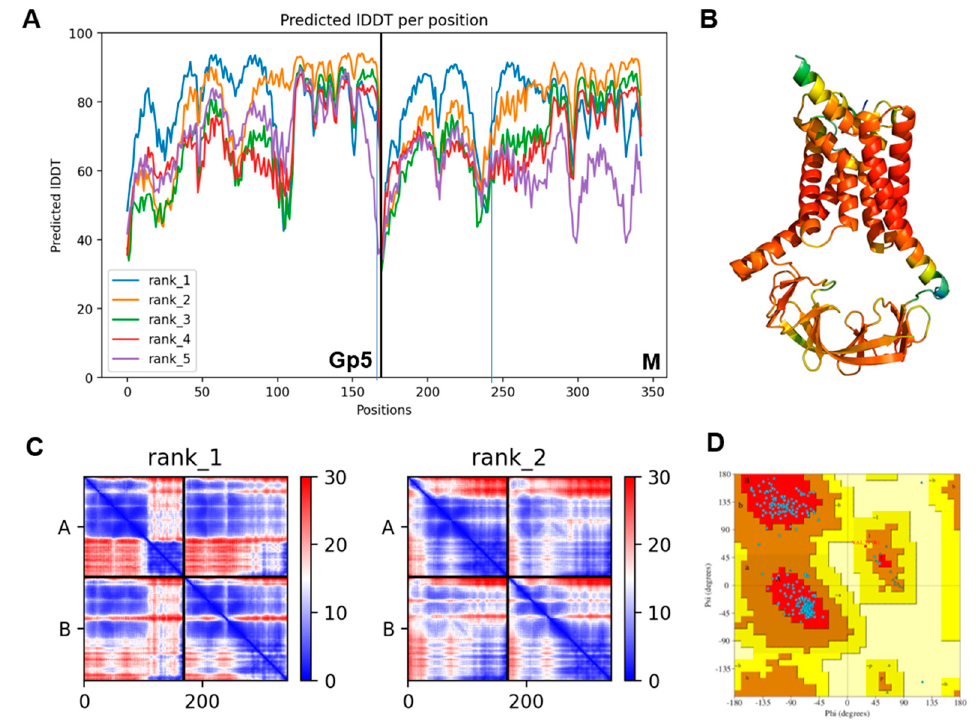
Figure 1. Confidence metrices for the predicted structure of Gp5/M of PRSSV-2 strain VR 2332: ( A ) Predicted local distance difference test (LDDT) score per position for the five models generated by alphafold2. The amino acid position is plotted against the predicted LDDT. Values between 70 and 90 indicate a high accuracy, where the prediction of the main chain of the protein is reliable. pLDDT values above 90 indicate very high accuracy, equivalent to structures determined by experiments. Values between 50 to 70 indicate a lower accuracy, but it is likely that the predictions of individual secondary structures are correct. ( B ) Cartoon model of the structure of Gp5/M showing the pLDDT per position, which is integrated as the b-factor in the PDB file delivered by alphafold2 in rainbow colors ranging from red (high confidence) to blue (low confidence). ( C ) Prediction aligned error (PAE) score for models ranked 1 and 2. This score displays the calculated error of the predicted distance for each pair of residues. Both axes indicate the position of the individual amino acids. The uncertainty in the predicted distance of two amino acids is color coded from blue (0 Å) to red (30 Å), as shown in the right bar. The color of the intersection of a horizontal line drawn from the posi- tion of an amino acid on the y-axis and a vertical line from the position of another amino acid on the x-axis indicates the error in the predicted distance between these two residues. PAE graphs are al- ways characterized by a diagonal blue line, since amino acids that are juxtaposed in the primary sequence are also adjacent in the 3D structure. The upper left quadrant corresponds to errors in the distances of residues within Gp5, the lower right quadrant to errors within M, the upper right quad- rant to errors between Gp5 and M, and the lower left quadrant to errors between M and Gp5. Note that model 1 has a lower error for the distances of the ectodomains, both within Gp5 and M and also between them. The errors for the transmembrane regions are very similar in both models. The error in the distances within and between the endodomains are also similar, but model 1 has a larger error in the distances between the endodomain and the transmembrane region. Note, however, that the differences between both models are rather marginal since both can be very well superimposed (Figure S1). ( D ) Ramachandran plot of the predicted structure of model 1. It shows the energetically allowed regions for backbone dihedral angles ψ against φ of amino acid residues in the Gp5/M structure. The φ -angle is the angle of the bond between the C α -atom (which carries the amino acid side chain) to the N-atom, and the ψ -angle is the angle between the C α -atom and the other C-atom of the peptide. For steric reasons, only certain combinations of ψ and φ angles are allowed. The red, brown, dark yellow and light yellow regions represent the favored, allowed, “generously allowed” and unallowed regions, respectively. Only one amino acid lies in the generously allowed region and none in the unallowed regions.